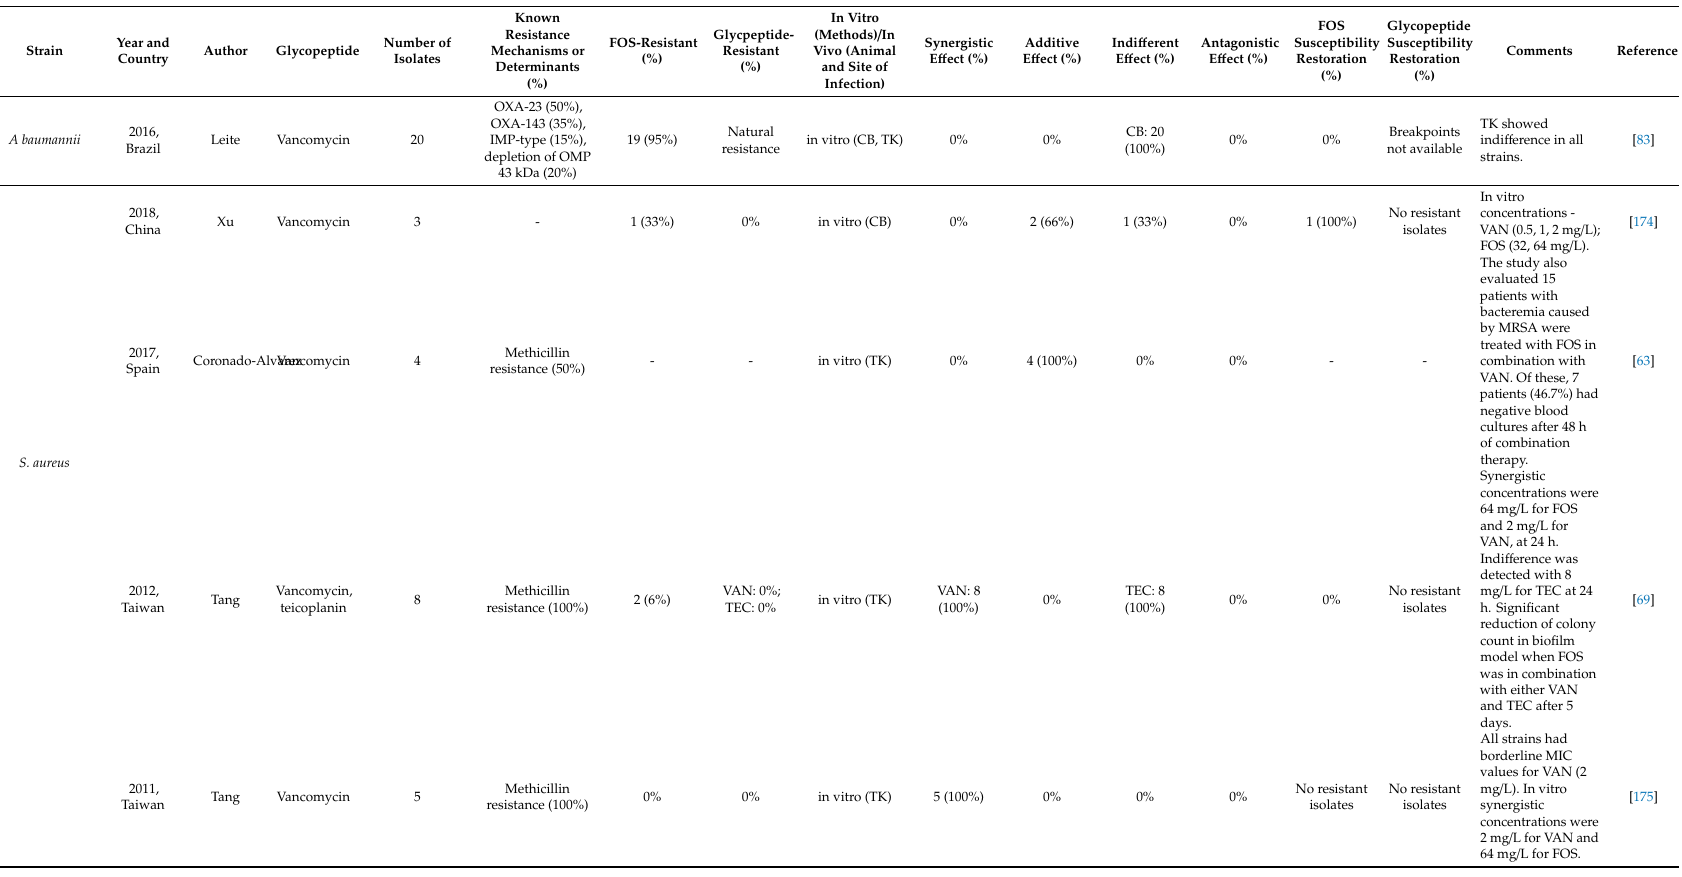
Table 8. Studies on combination between fosfomycin and glycopeptides. CB: checkerboard assay; TK: time–kill assay; ET: